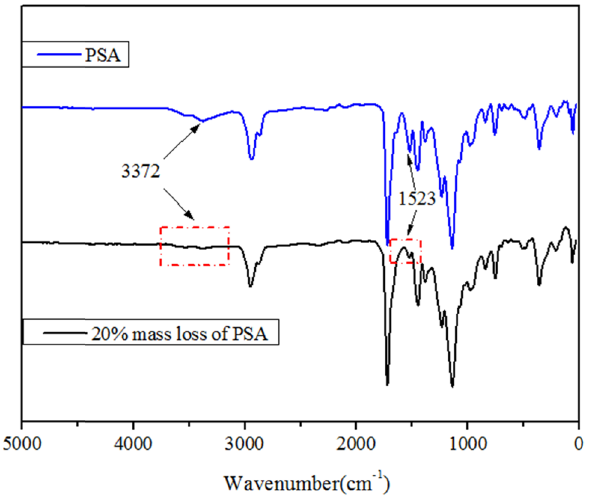
Figure A1: Infrared spectra of PSA at di ff erent thermal degradation